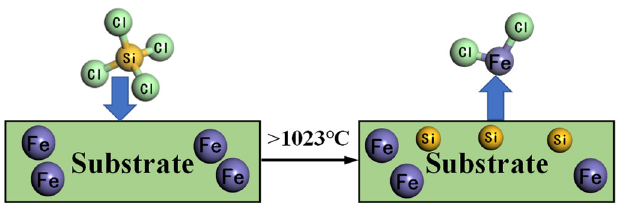
Figure 1. Schematic diagram of Fe-6.5 wt%Si silicon steel prepared by the CVD